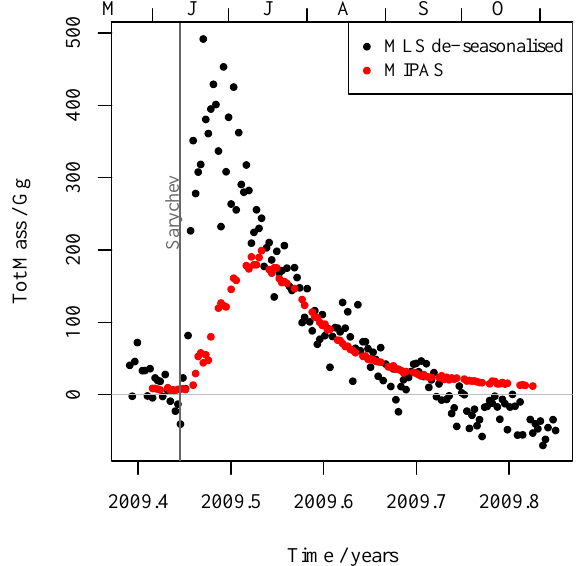
Figure 13. Comparison between daily values of global mass of SO 2 above 146.8hPa after the Sarychev eruption from MIPAS (red) and from MLS deseasonalized observations (black) (Pumphrey et al., 2015).